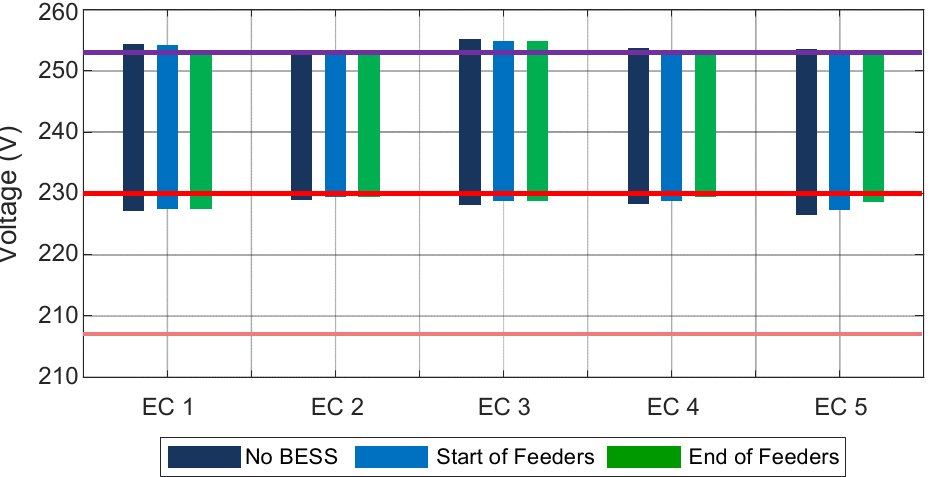
Figure 15. Bar graph of node voltage variations for each EC with and without the community BESS. The horizontal lines represent the 230 V ± 10% nominal voltage range for the Maltese LV network: Maximum limit (Purple), Nominal voltage (Red) and minimum voltage (Pink).